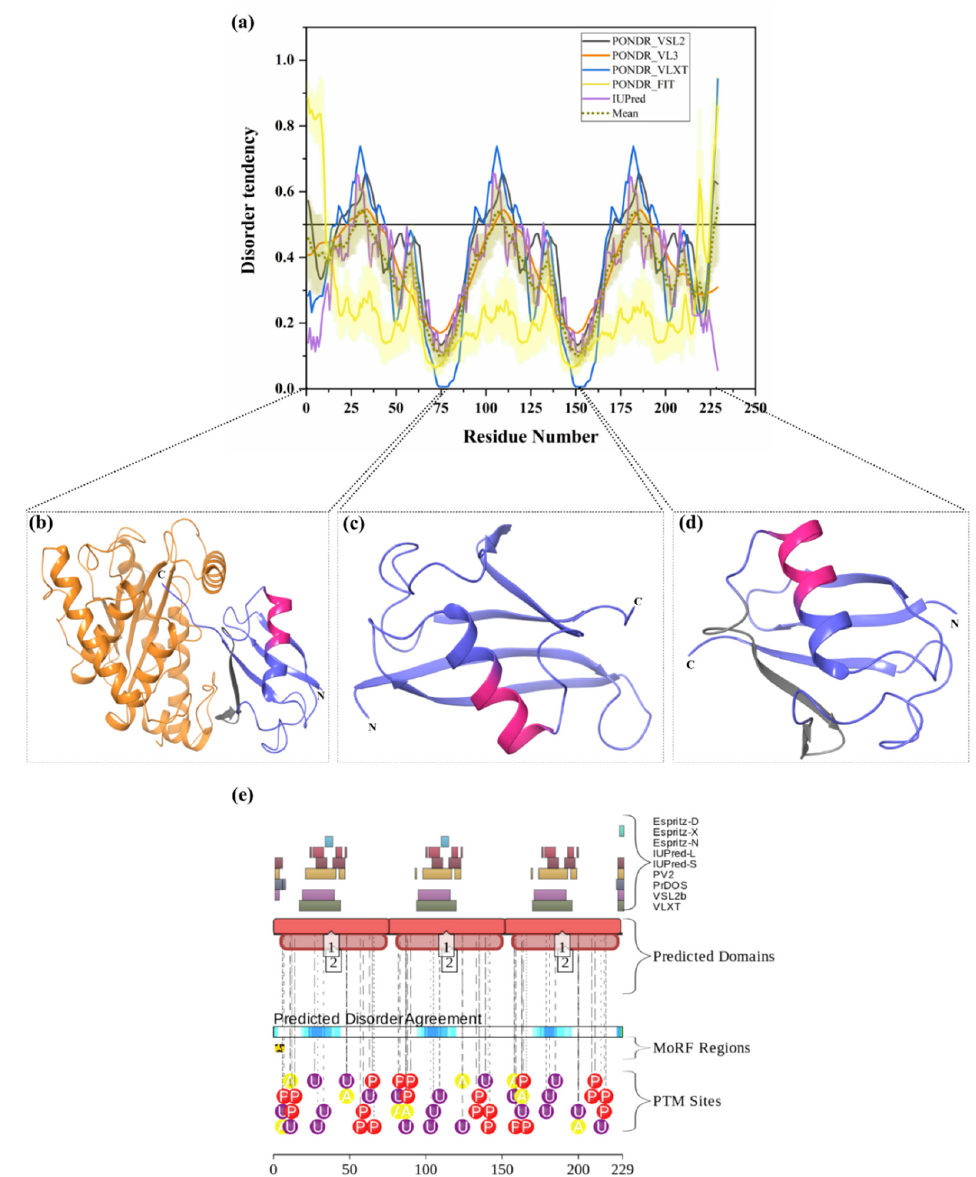
Figure 5. Analysis of intrinsic disorder predisposition in polyubiquitin-B (UBB) and structural characterization of mature ubiquitins. ( a ) Disorder analysis of human polyubiquitin-B (UniProt ID: P0CG47). ( b ) Crystal structure of chain B of Polyubiquitin-B (PDB ID: 6FDK). ( c ) Crystal structure of Chain D of Polyubiquitin-B (PDB ID: 6BYH). ( d ) Crystal structure of Chain A of Polyubiquitin-B (PDB ID: 4XOF). In Plot ( a ), the disorder profile obtained forms a set of disorder predictors such as PONDR ® VSL2, PONDR ® VL3, PONDR ® VLXT, PONDR ® FIT and IUPred, represented by black, orange, blue, yellow, and purple curves respectively. Mean disorder profile, which was calculated from average of five predictor-specific per-residue disorder profiles, is shown in olive color. Predicted disorder scores above 0.5 are considered as disordered residues / regions. The light-olive shadow around the mean curve represents the error distribution for the mean. The light-yellow shadow around the PONDR ® FIT curve shows the error distribution for PONDR ® FIT. In Plot ( b ), a structure of Ub protein (faded blue) in complex with Chlamydia trachomatis e ff ector protein Cdu1 (orange color) is represented. In Plots ( b ), ( c ), and ( d ), Ub is shown in faded blue color, and disordered residues are shown in salmon pink color. The position of MoRFCHiBi_Web-server-identified MoRFs (residues 40–50, shown in PDB ID:6FDK, and residues 192–202, shown in PDB ID: 4XOF) are represented by grey color. ( e ) Functional disorder profile of the UBB protein, using the D2P2 server, is shown.